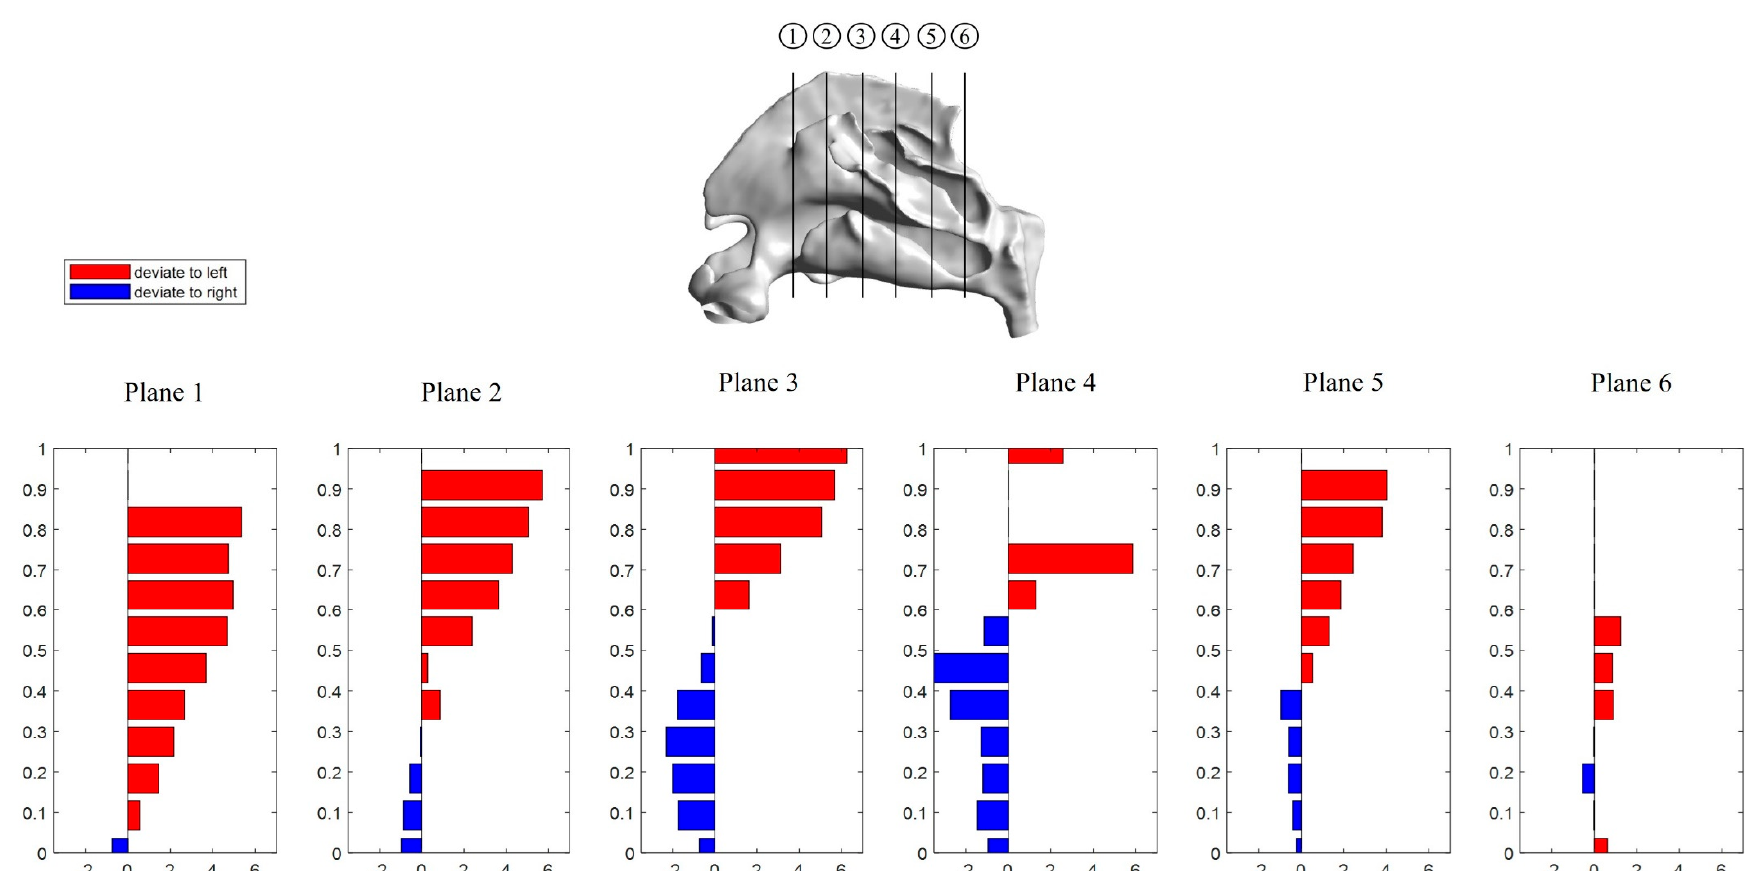
Figure 6. Septum deviation assessment at six planes taken along the nasal airway passage that being perpendicular to airflow direction. Planes were labelled as Plane 1, 2, 3, 4, 5, 6 and the physical meaning of the zero position of the horizontal axis stands for the location where the right septal wall coincides with the left side.